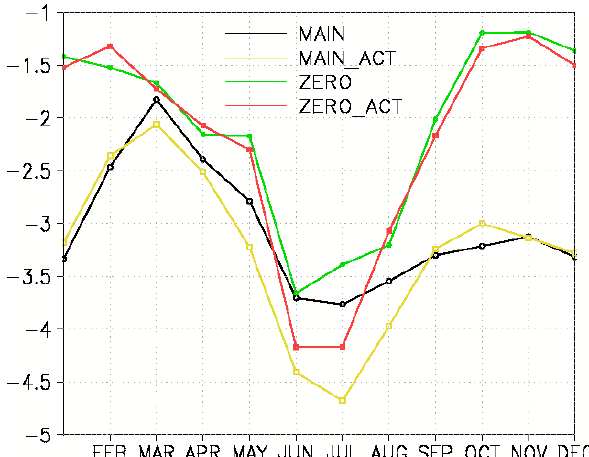
Figure 3. Seven-year monthly mean radiative forcing (in Wm − 2 ) in the area 65–90 ◦ E, 5–35 ◦ N at the TOA in the MAIN and MAIN_ACT simulations with GAINS emissions without aerosol cloud activation (black) and with aerosol cloud activation (yel- low) and in the ZERO the ZERO_ACT simulations without anthro- pogenic emissions without cloud activation (green) and with aerosol cloud activation